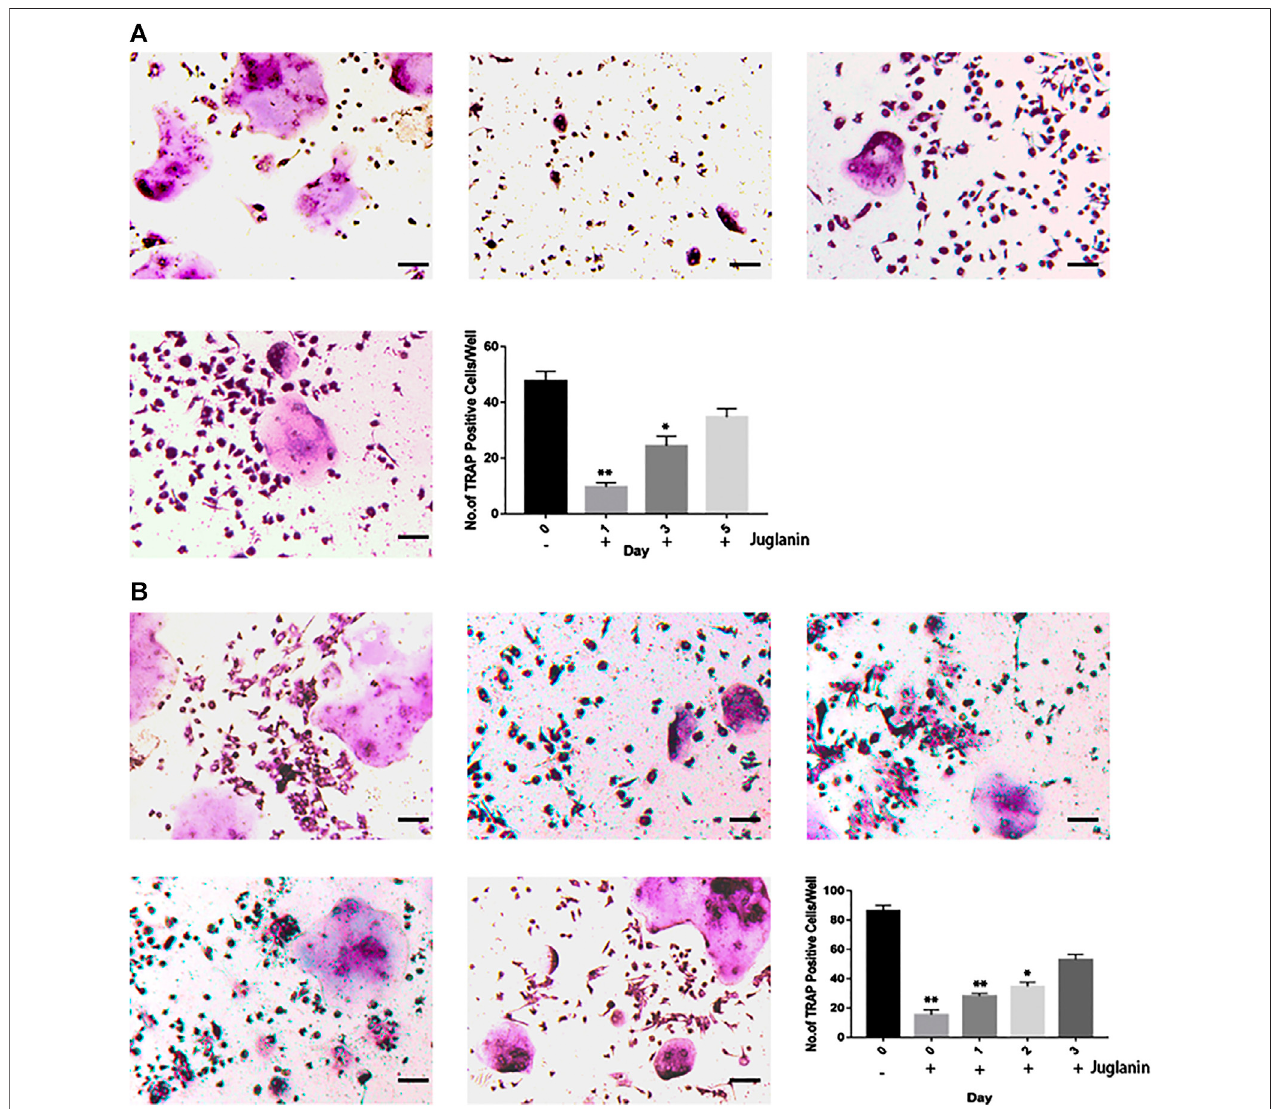
FIGURE 3 | JUG inhibits RANKL-induced osteoclast formation at the early stage. (A) Effect of JUG on RANKL-induced BMMs differentiation at different stage (B) Effect of JUG on RANKL-induced RAW264.7 cell differentiation at different stages. Scale bar 100 μ m. Data are presented as the mean ± SEM, * p < 0.05, ** p < 0.01 relative to the control group. n (cid:2)